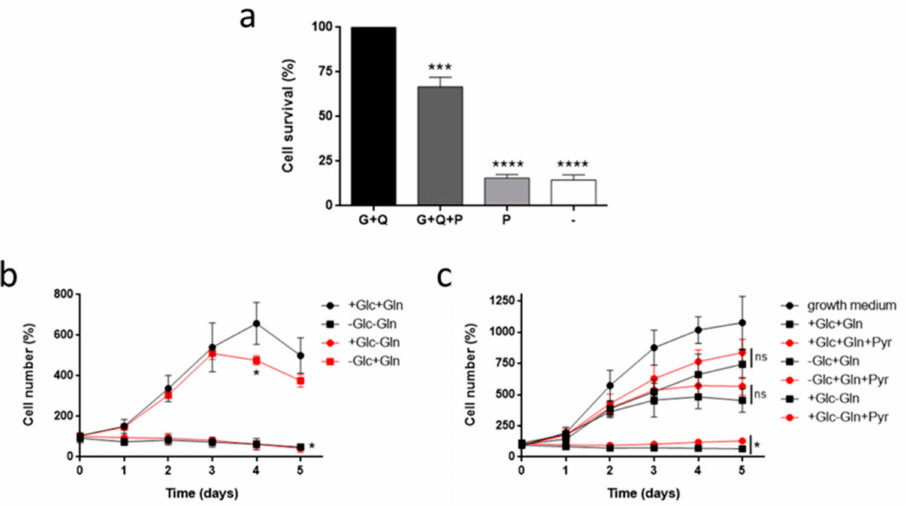
Figure 1. HMEC growth under di ff erent nutritional conditions. ( a ) Cell survival after 6 h incubation in DMEM supplemented with 5 mM glucose (G), 0.5 mM glutamine (Q) and / or 0.5 mM palmitate (P). ( b ) HMEC growth was monitored in the presence or absence of 5 mM glucose and / or 0.5 mM glutamine and ( c ) 5 mM glucose and / or 0.5 mM glutamine with and without 1 mM sodium pyruvate. Data are expressed as means ± SD of three independent experiments. * p < 0.05, *** p < 0.001, **** p < 0.0001 versus glucose and glutamine condition ( a , b ) or condition without pyruvate ( c